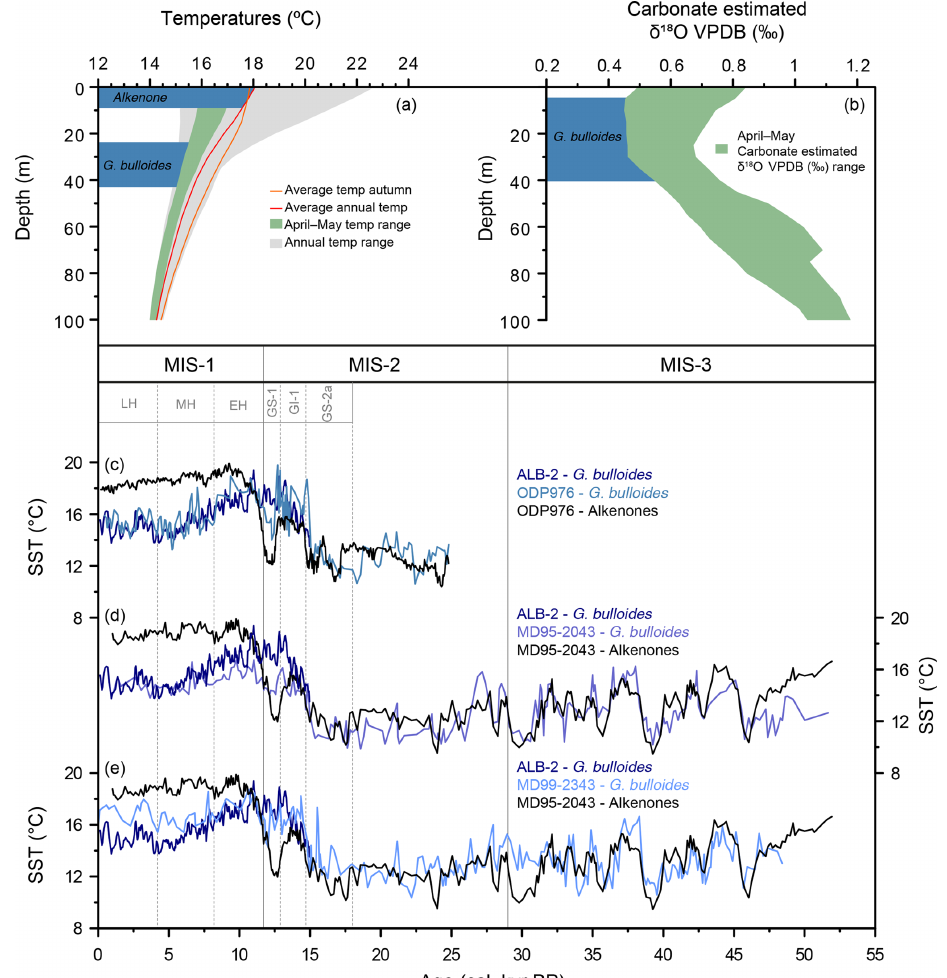
Figure 4. Western Mediterranean SST from alkenone and G. bulloides Mg / Ca multi-comparison for the last interglacial and the following (present) interglacial period. (a) Temperatures. (b) Carbonate estimated δ 18 O VPDB (‰) profile for the first 100m from site 503737B, obtained from WOA13 0.25deg measured during the years 1955–2012 (Boyer and Mishonov, 2013). The horizontal blue band indicates the preferential depth in relation to the profile temperatures (a) and carbonate estimated δ 18 O VPDB (‰) (b) of G. bulloides (average April–May temperatures and carbonate estimated δ 18 O VPDB (‰) in green) and alkenones (annual average temperatures in red). Note that each of the following comparisons have the same y axis. (c) The blue lines (ALB-2; this study and ODP976; Jiménez-Amat and Zahn, 2015) show G. bulloides Mg / Ca SST compared with the alkenone SST (Martrat et al., 2014) from the same ODP976 record. (d) The blue lines (ALB-2 and MD95-2043; both in this study) show G. bulloides Mg / Ca SST compared with the alkenone SSTs from the same MD95-2043 record (Cacho et al., 1999). (e) The blue lines (ALB-2 and MD99-2343; both in this study) show G. bulloides Mg / Ca SST compared with alkenone SST from the MD95-2043 record (Cacho et al.,